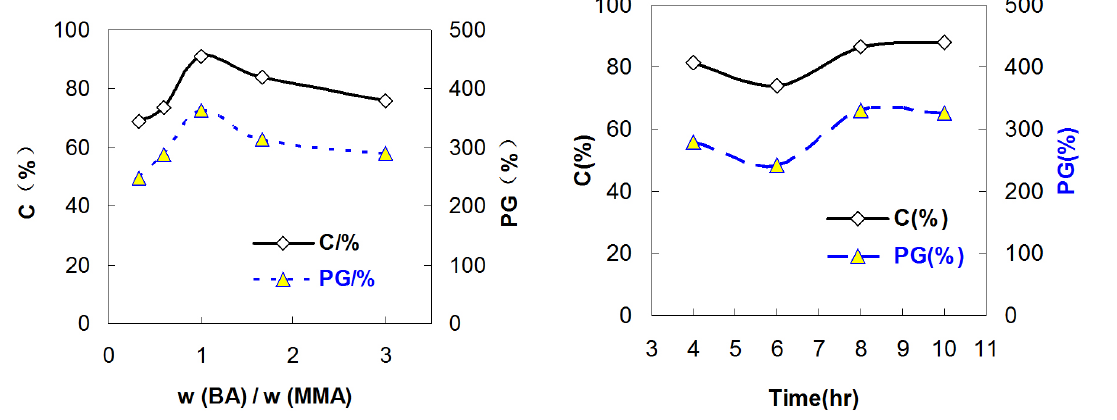
Figure 6. The effect of reaction temperature on C% and PG%(Cond.: w(BA) / w(MMA) = 1:1, w(PoSt) / w(Monomers) = 1:4, KPS: 1.50 wt.%, Time: 8